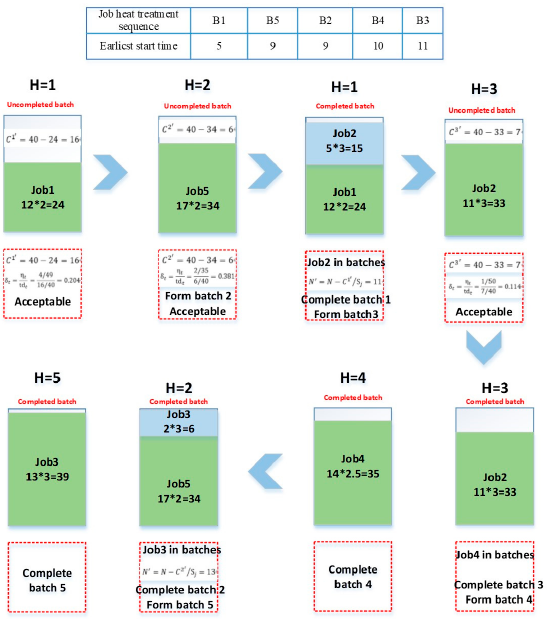
Figure 4 Figure 4. Heat Treatment Decoding Process